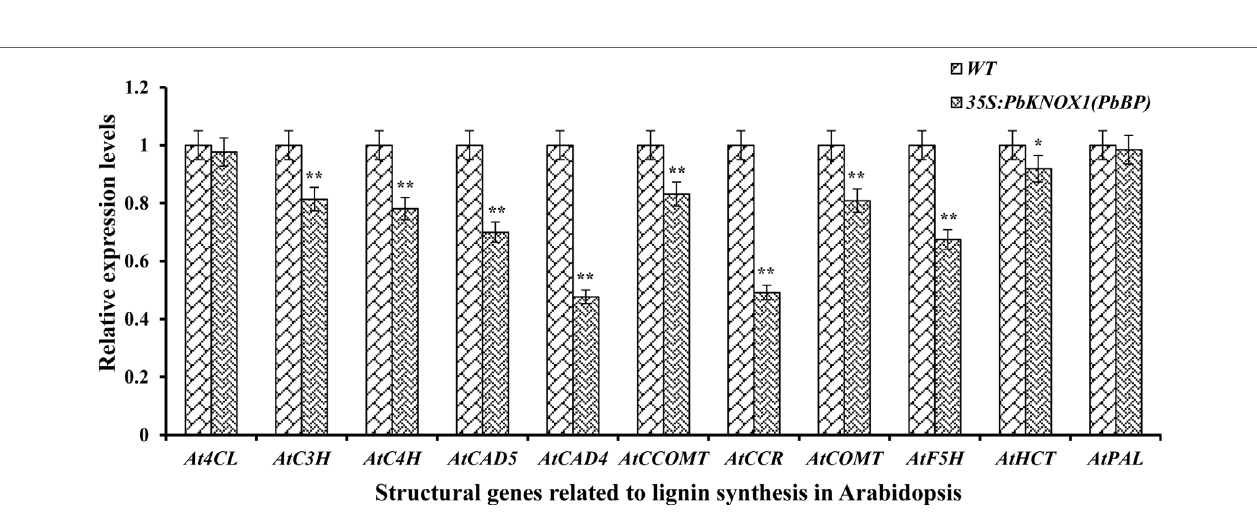
FIGURE 9 | The expression of eleven lignin genes was profiled by qRT-PCR in the inflorescence stem of the wild-type and PbBP -overexpressing transgenic lines. WT: wild-type Arabidopsis ; 35S::PbKNOX/BP : PbBP -overexpressing transgenic lines. ** p < 0.01; * p <